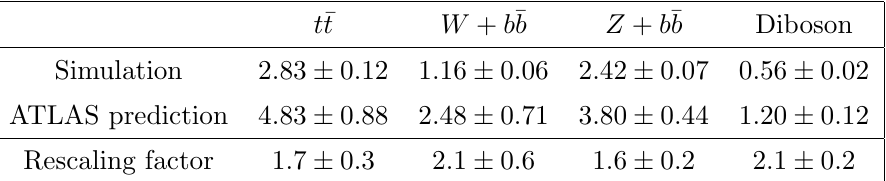
Table 1 . Predicted number of events with 80 GeV (cid:20) m J (cid:20) 280 GeV according to our simulation and in ATLAS [67], as well as the resulting rescaling factors. For the results of our simulation we quote the uncertainties resulting from limited MC statistics. The uncertainties in the rescaling factors re(cid:13)ect the uncertainties in the background estimates from